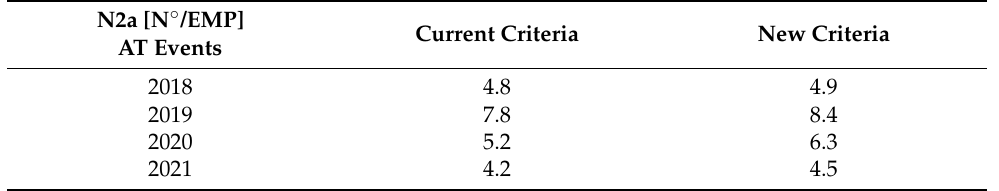
Table 10. N2a comparison: HV